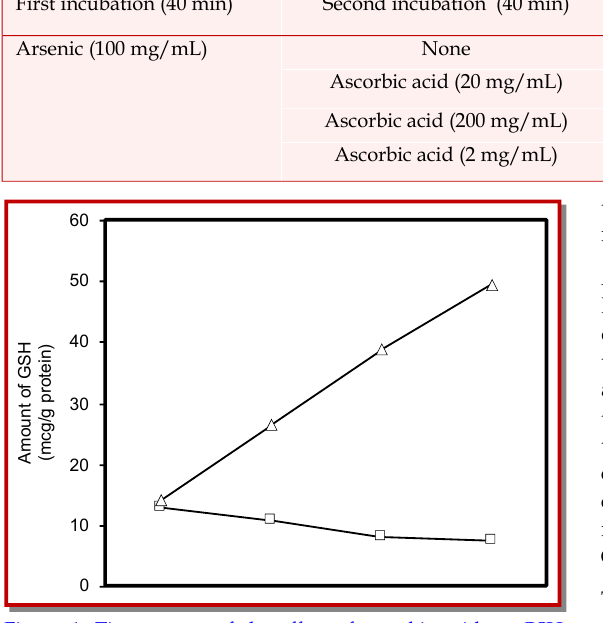
Figure 1: Time course of the effect of ascorbic acid on GSH level in arsenic loaded liver